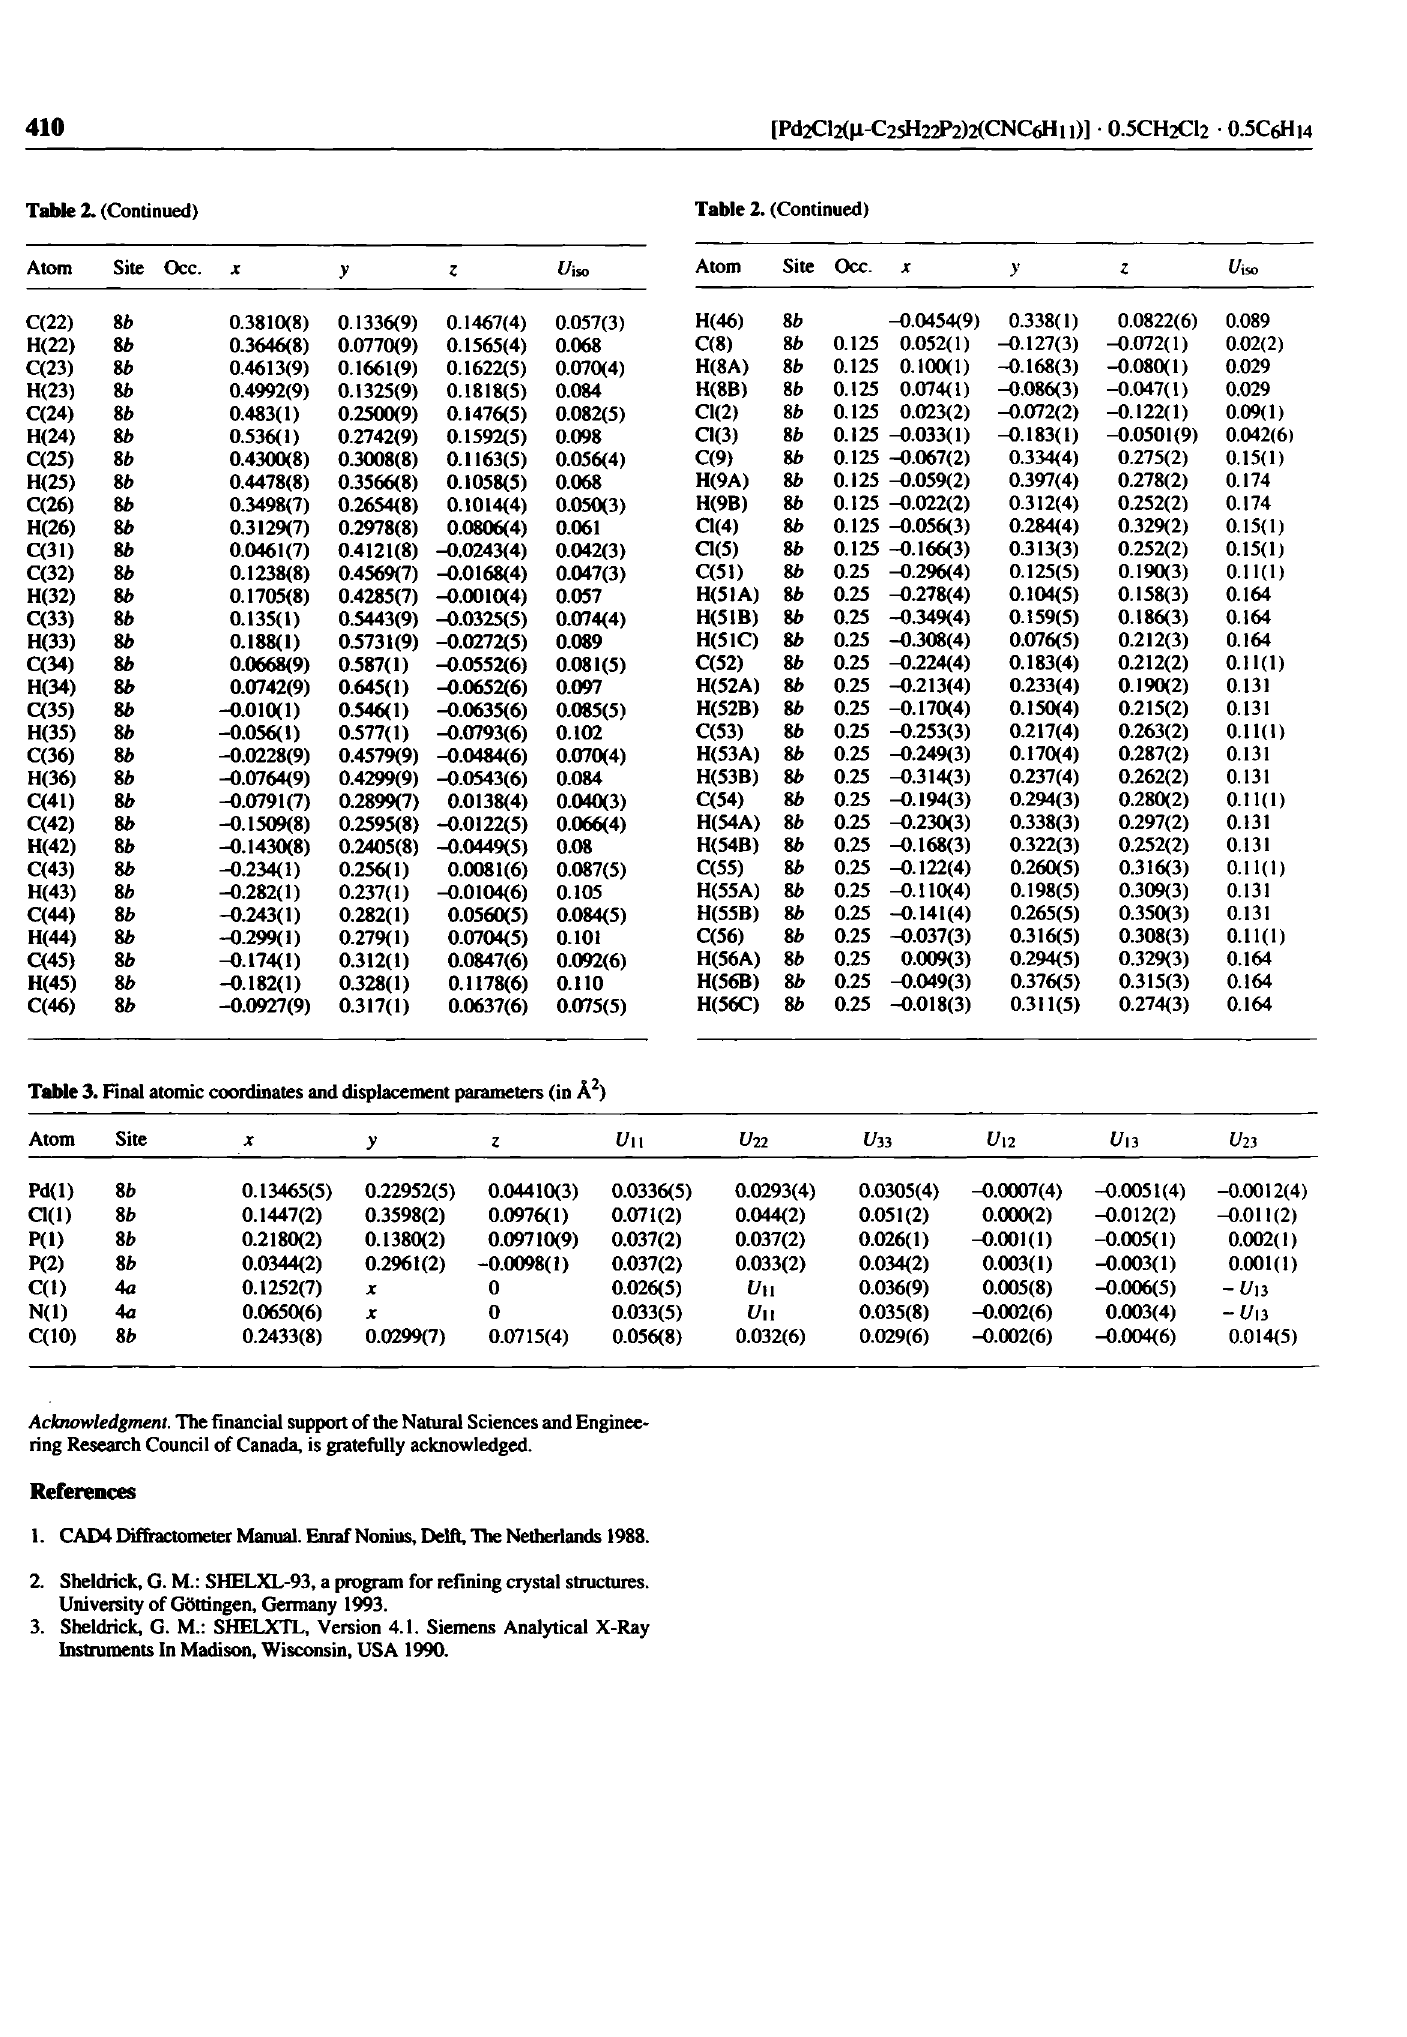
Table 3. Final atomic coordinates and displacement parameters (in Â 2